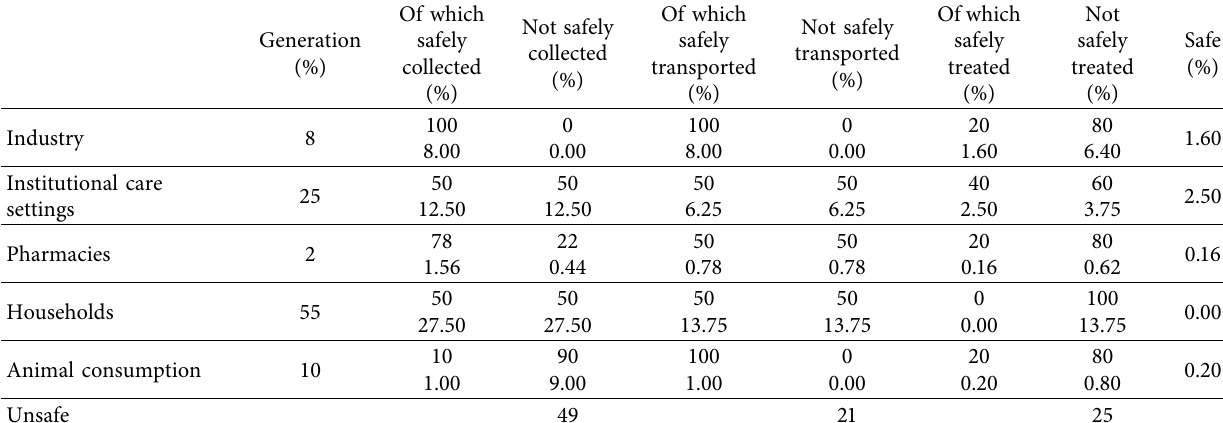
Table 2: Drug disposal matrix for Krowor